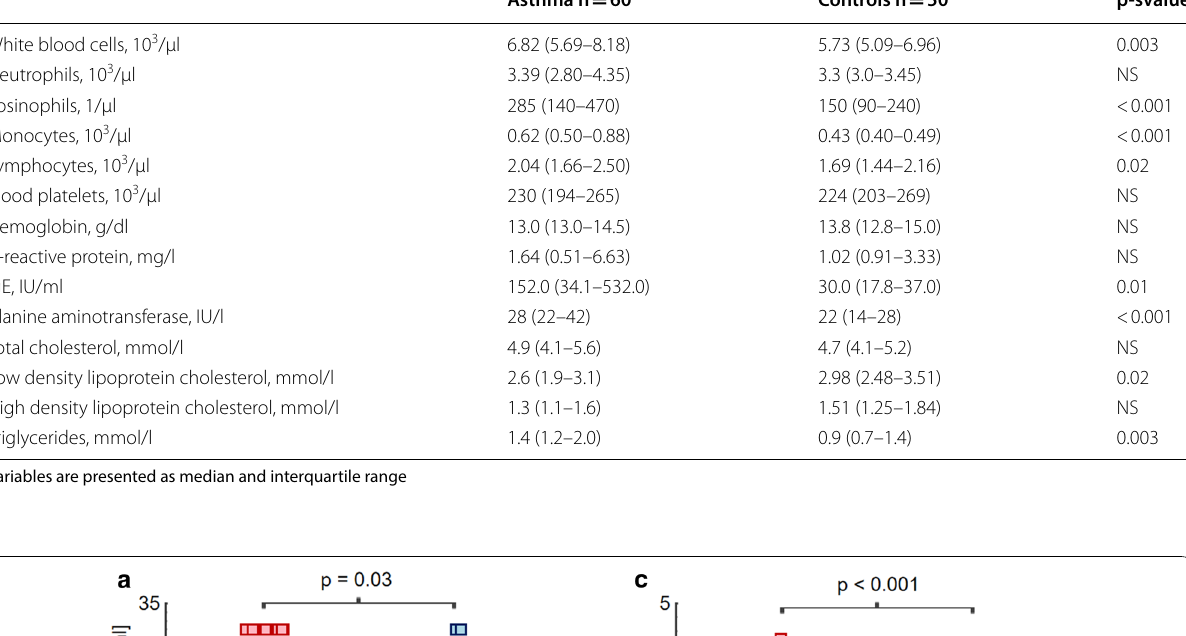
Table 2 Peripheral blood basic laboratory results